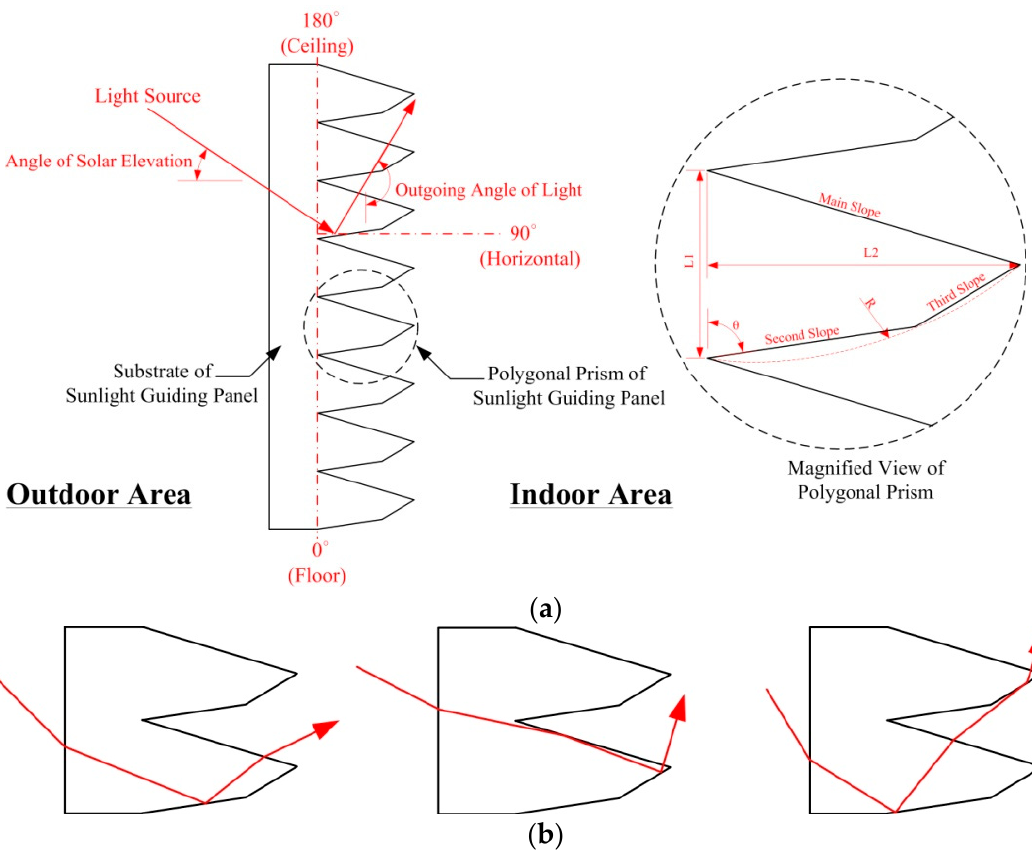
Figure 4. Feature of the proposed sunlight guiding panel. ( a ) Structure definition method. ( b ) Predicted optical path for indoor lighting.